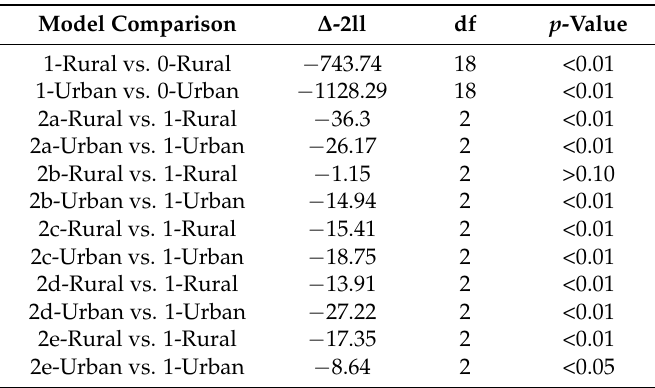
Table 3. The likelihood chi-squared